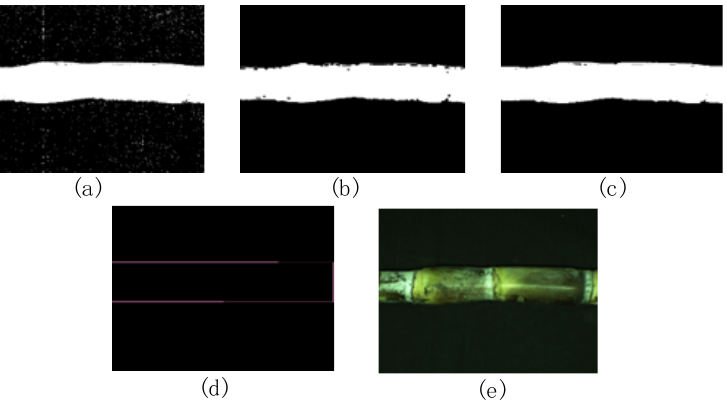
Figure 4. Preprocessing of sugarcane images: ( a ) inverse binary image, ( b ) corroded image, ( c ) dilated image, ( d ) circumscribed rectangle, and ( e ) image after correction.